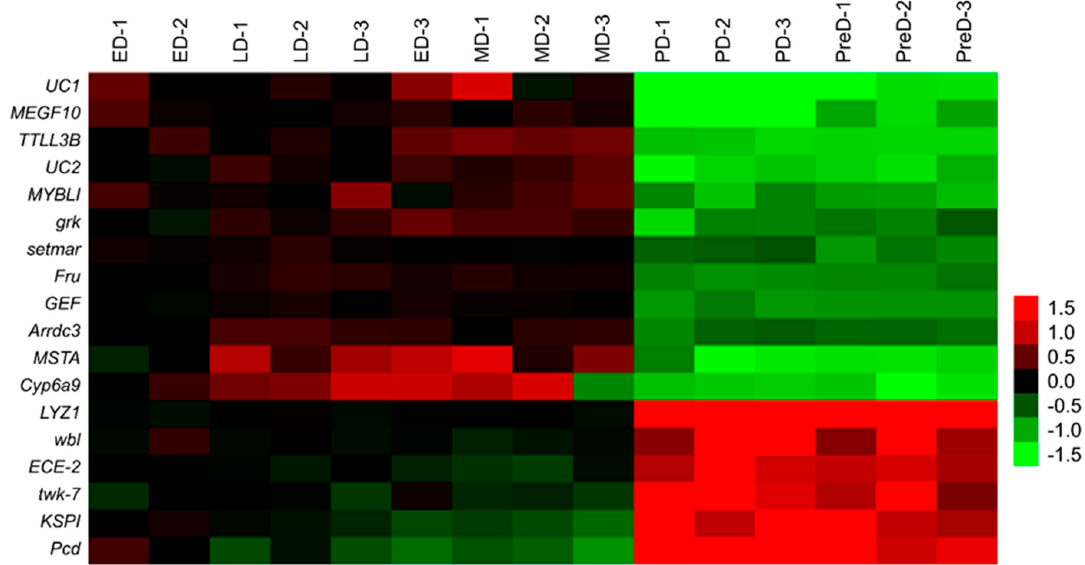
Figure 1. Heat map of expression levels of 18 putative diapause-associated genes throughout the pupal stage of B. minax according to the reads per kb of exon model per million mapped reads (RPKM) values. Red and green color gradients indicate the high and low expression levels, respectively. PreD, pre-diapause, 1 d after pupation; ED, early-diapause, 57 d after pupation; MD, middle-diapause, 75 d after pupation; LD, late-diapause, 95 d after pupation. PD, post-diapause, 135 d after pupation.